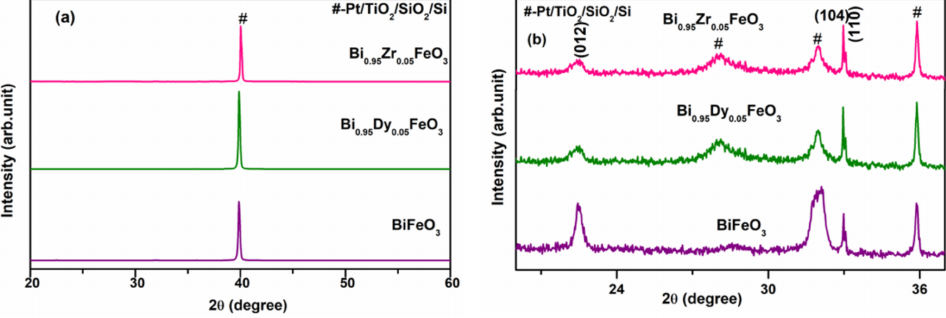
Figure 2. ( a ) XRD pattern of BFO, BDFO, and BZFO thin films (2 θ range is 20 ◦ to 60 ◦ ); ( b ) XRD pattern of BFO, BDFO, and BZFO thin films (2 θ range is 20 ◦ to 38 ◦